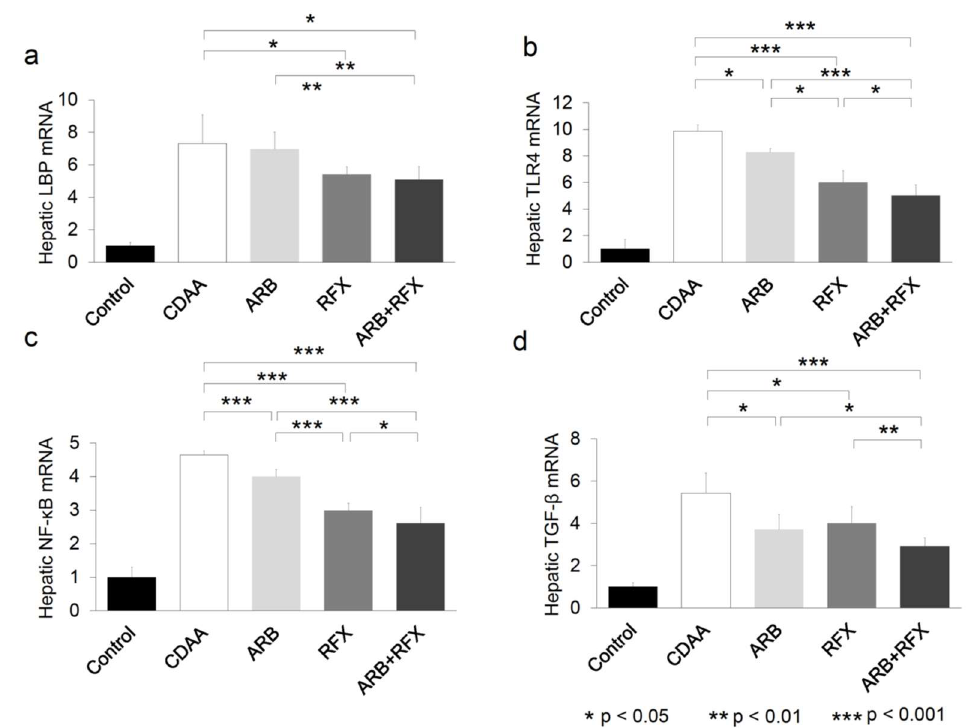
Figure 5. ( a ) Semiquantification of RT-PCR results of hepatic LBP mRNA. ( b ) Semiquantification